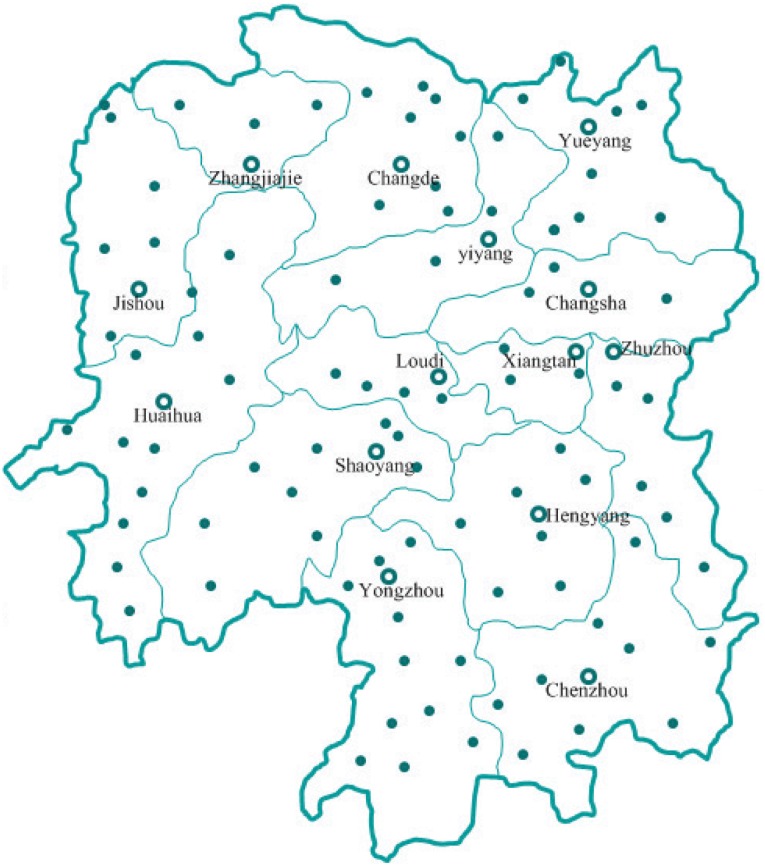
Demand points of the case example.